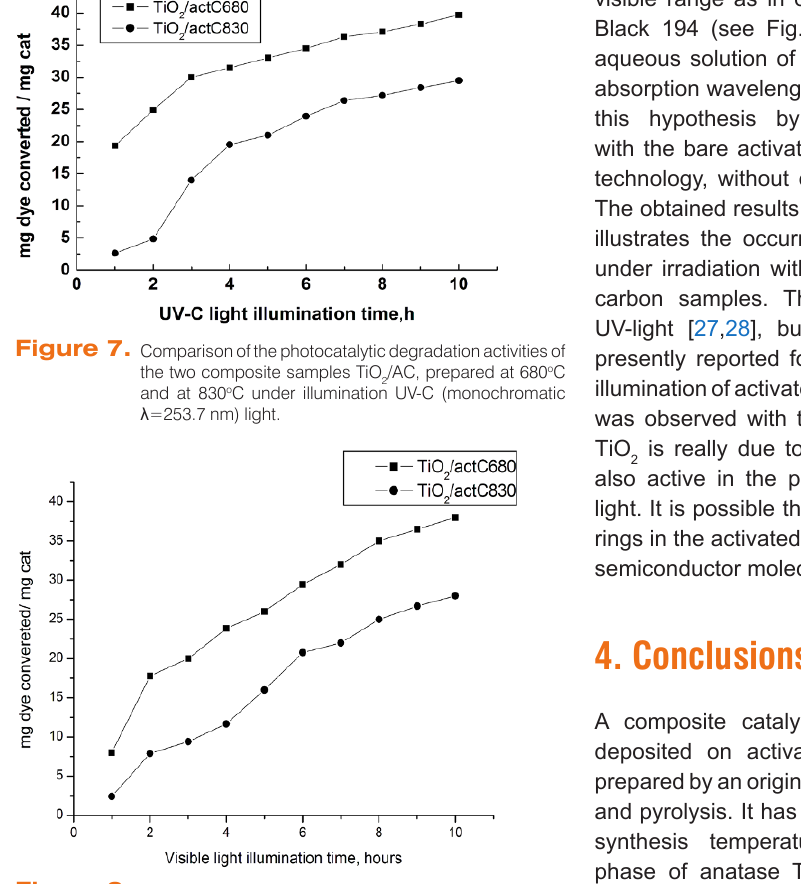
/AC, prepared at 2